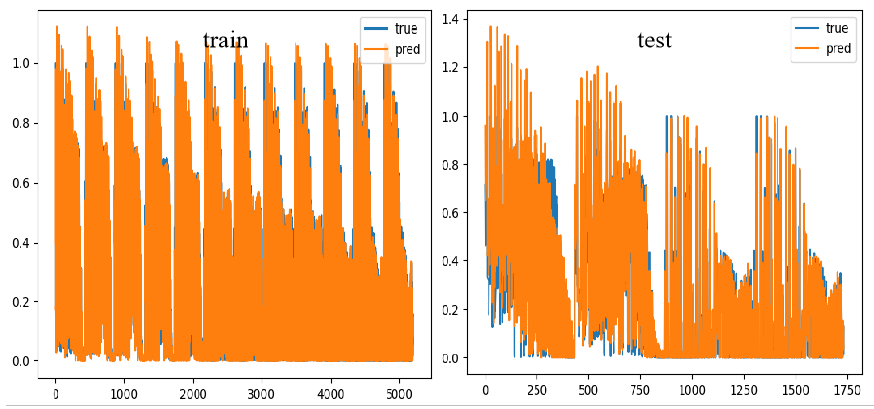
Figure 8. Comparison of the actual and predicted normalized concentrations of the CNN